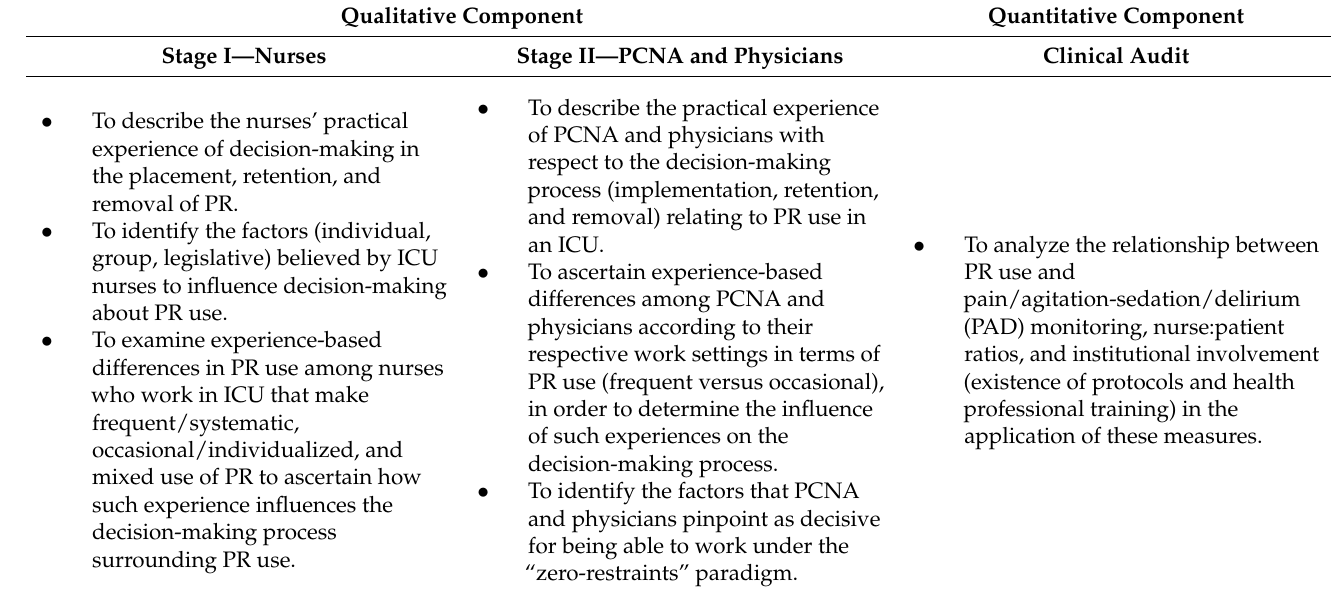
Table 1. Specific research